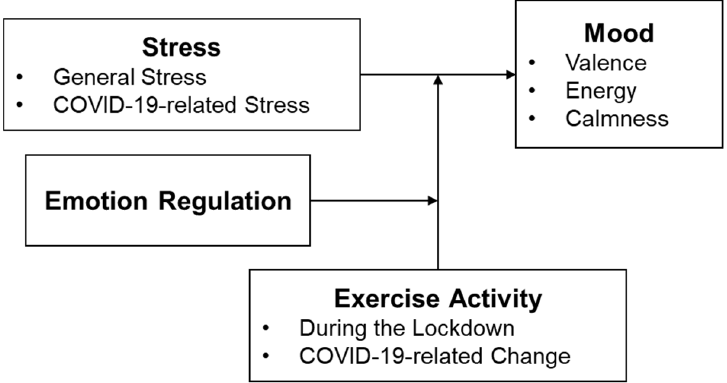
Figure 1. Three-way interaction model between stress, exercise activity, and emotion regulation on mood.